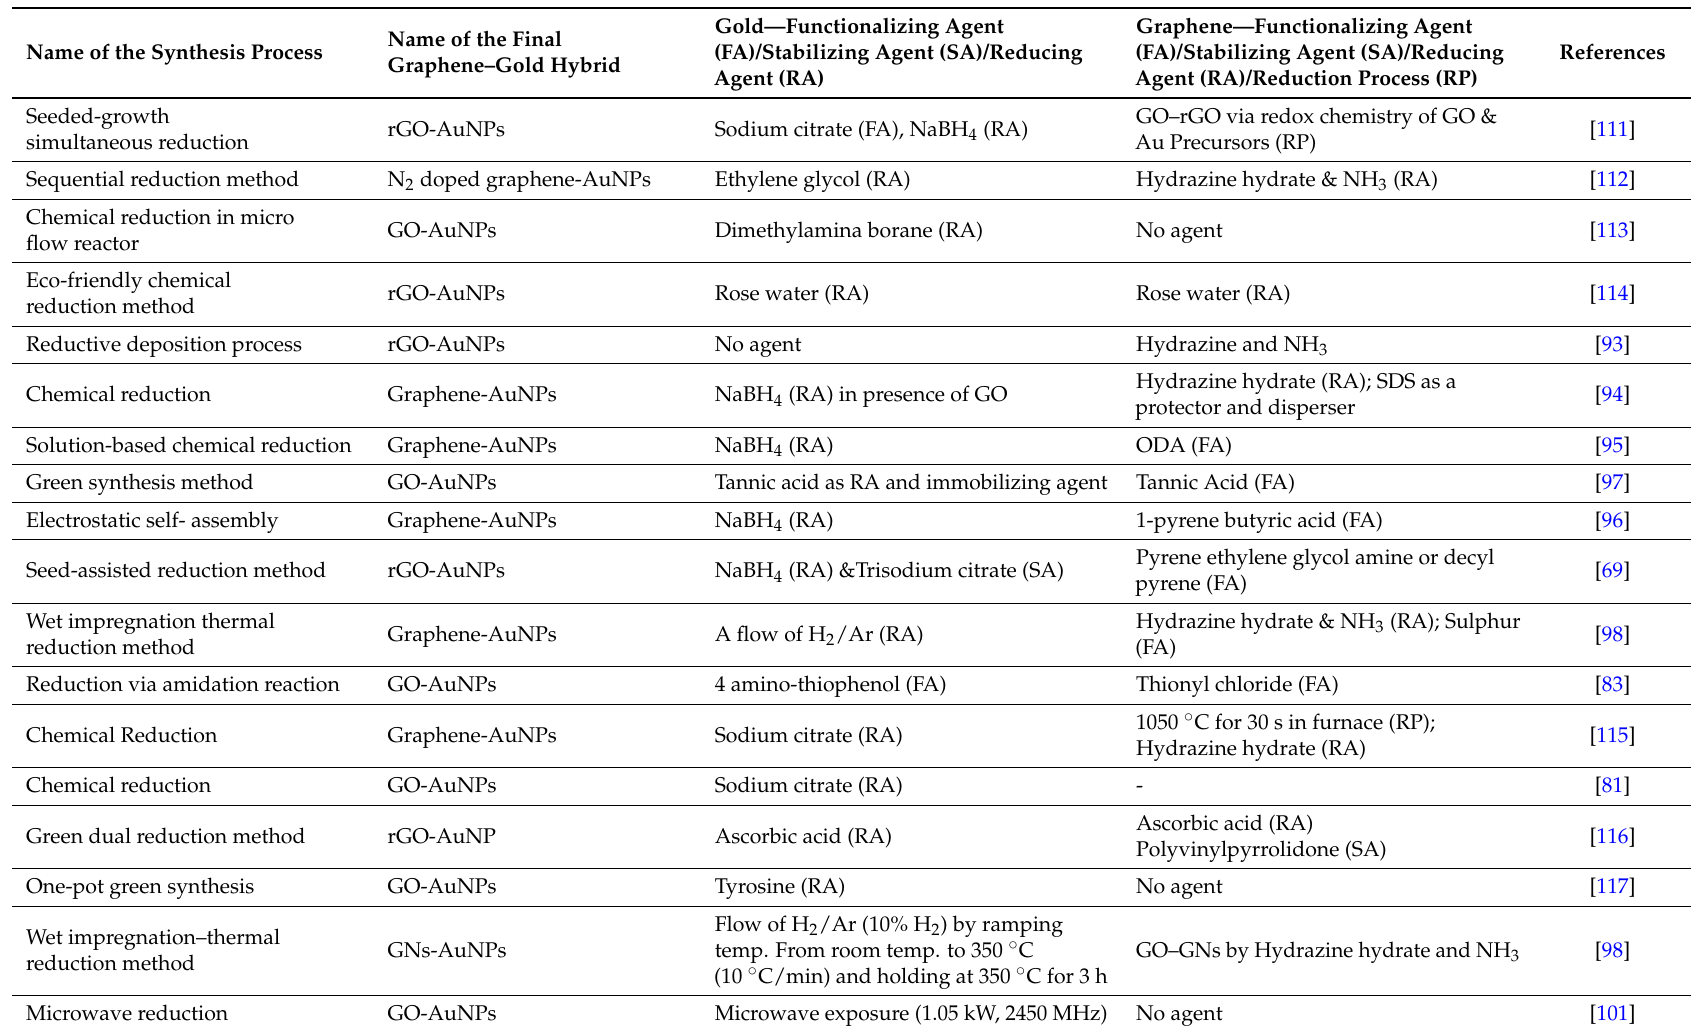
Table 4. Summary of the different synthesis approaches of graphene–gold